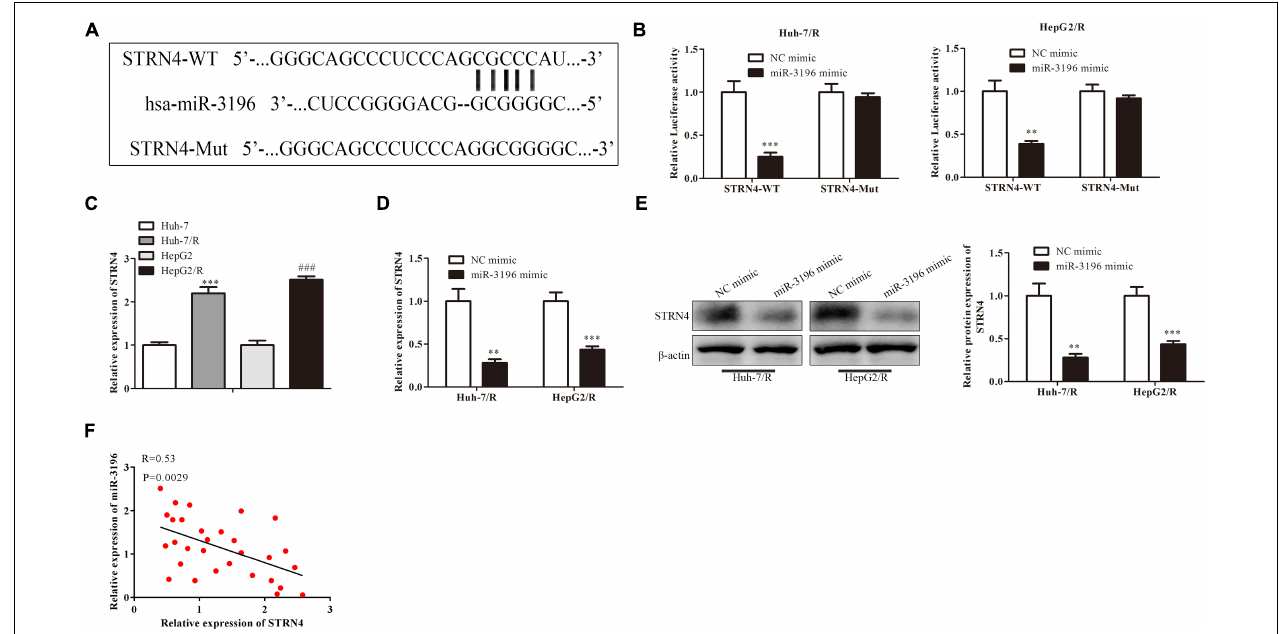
FIGURE 5 | MAFG-AS1 modulates STRN4 protein expression through targeting miR-3196 in liver cancer cells. (A) Schematic diagram shows the binding sites within miR-3196 and STRN4 mRNA 3 (cid:48) -UTR. (B) Luciferase reporter assay shows the molecular bond within miR-3196 and STRN4 mRNA 3 (cid:48) -UTR. (C,D) RT-PCR shows the STRN4 mRNA expression levels in Huh7/R and HepG2/R cells (C) or transfected with miR-3196 mimic (D) . (E) Western blot analysis quantified STRN4 protein expression in Huh7/R and HepG2/R cells transfected with miR-3196 mimic and negative control mimic. (F) Correlation analysis found a negative association between the expressions of miR-3196 and STRN4 in liver cancer cells. ** P < 0.01, *** P < 0.001, ### P < 0.001 vs Corresponding control